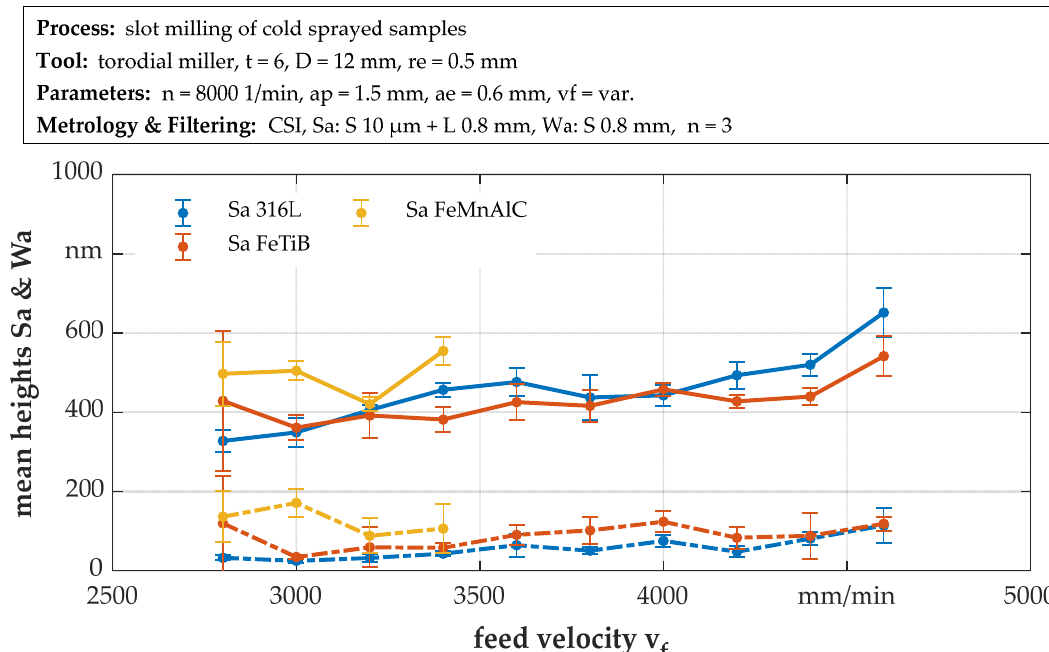
Figure 6. Surface mean heights Sa and Wa versus feed velocity. Error bars indicate standard deviation for repeated measurements on the same part.